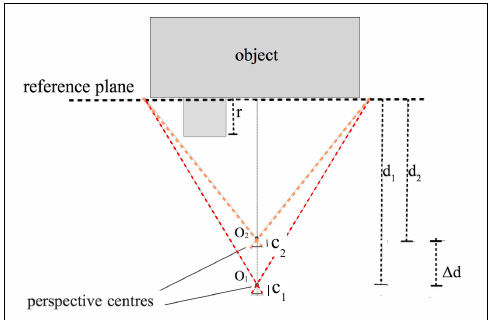
Figure 4. Bifocal scheme (planimetric projection)